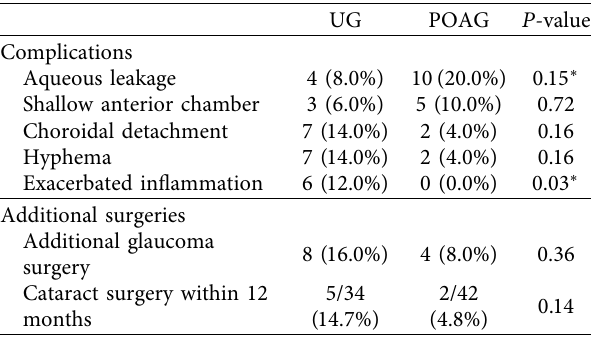
Table 4: Postoperative complications and additional